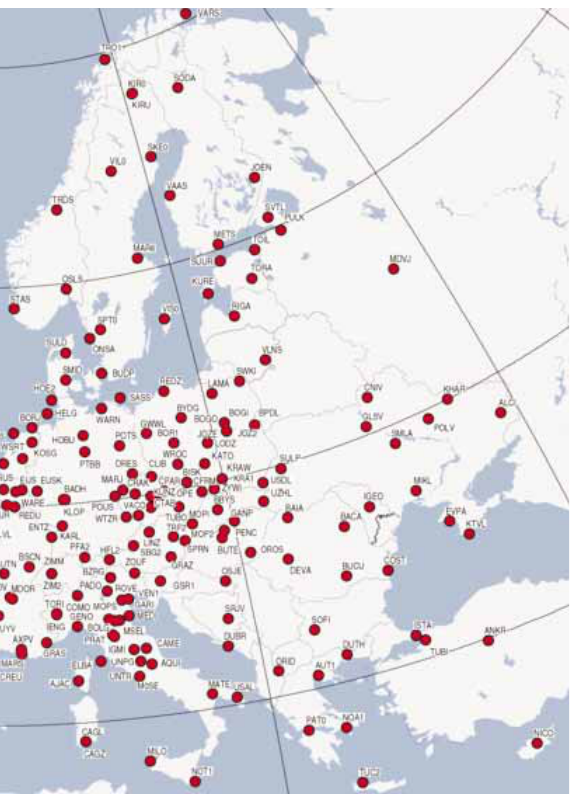
Fig. 1. A fragment of the EPN network map (EUREF… 2011)